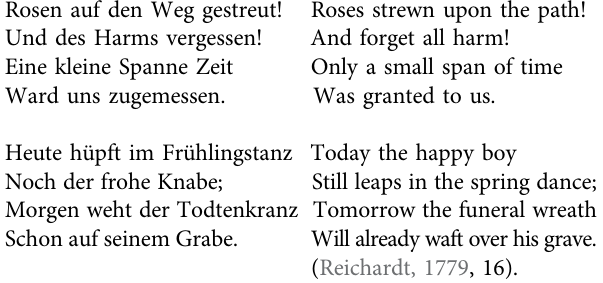
woman sit on the coach box, while two children peek out from the coach window, and a young boy rides one of the horses while waving a fl ag ( Figure 1 ). The boy ’ s excitement at the adventure to come is palpable, and this illustration would have prompted a similar excitement in the periodical ’ s readers as they “ joined ” the seven Salzmann children, their parents, their coachman, and their the children cry (5).